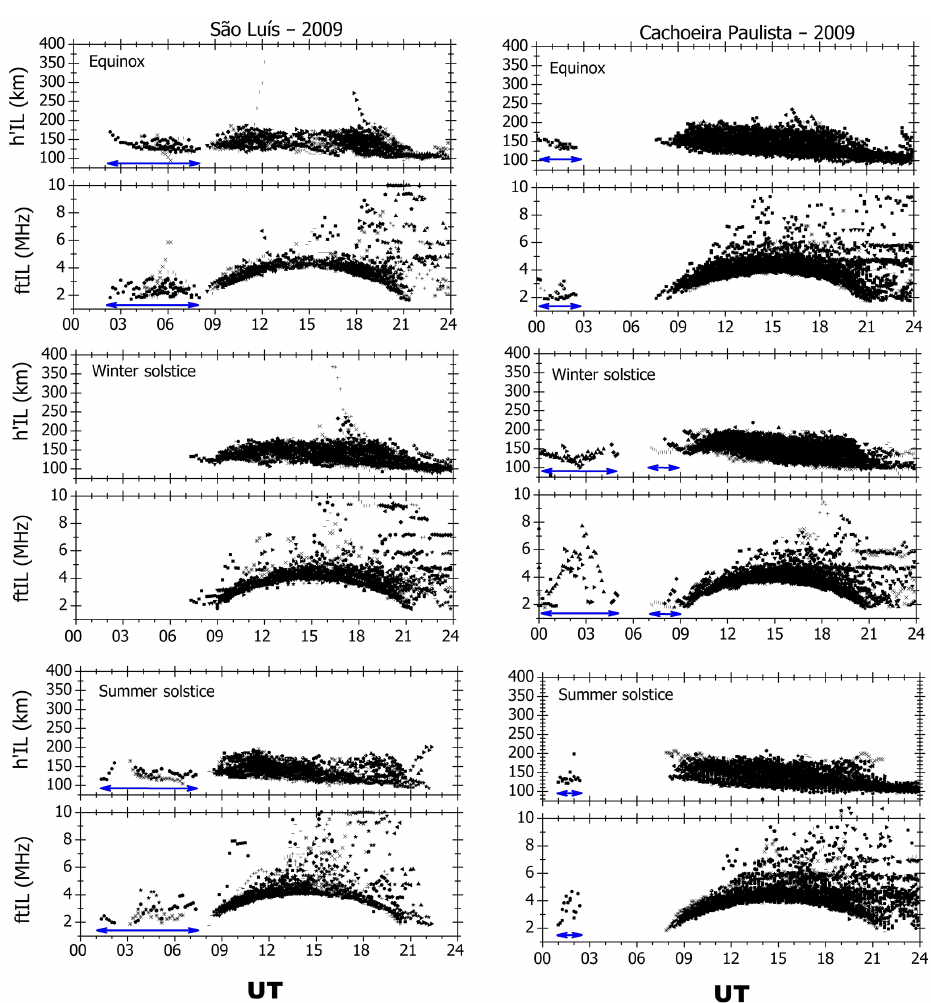
Figure 3. Time dependence of intermediate layer parameters over São Luís and Cachoeira Paulista for different seasons (column of panels of left and right, respectively). The horizontal blue arrow indicates the presence of nocturnal layers between 00:00 and